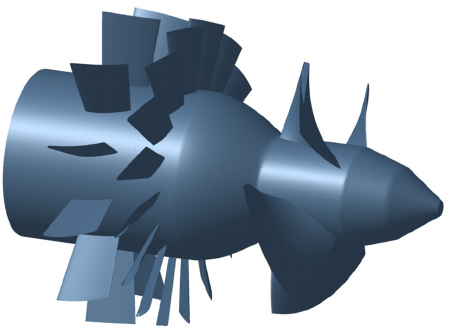
Figure 2. A 3D rendering of the regulating low-head axial flow hydraulic turbine.